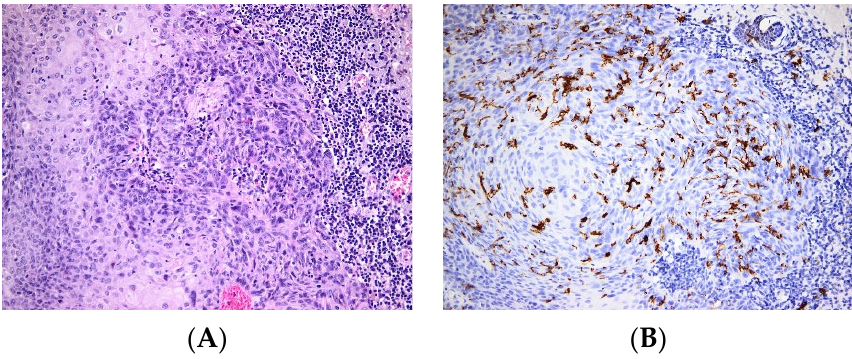
Figure 4. Langerhans cells in Squamous cell carcinoma . ( A ). Squamous cell proliferation with moderate cellular atypia; abundant peritumoral inflammatory infiltrate. HE × 200. ( B ). Numerous Langerhans cells present within the tumor mass with diffuse distribution in the tumoral structures. CD1a × 200.